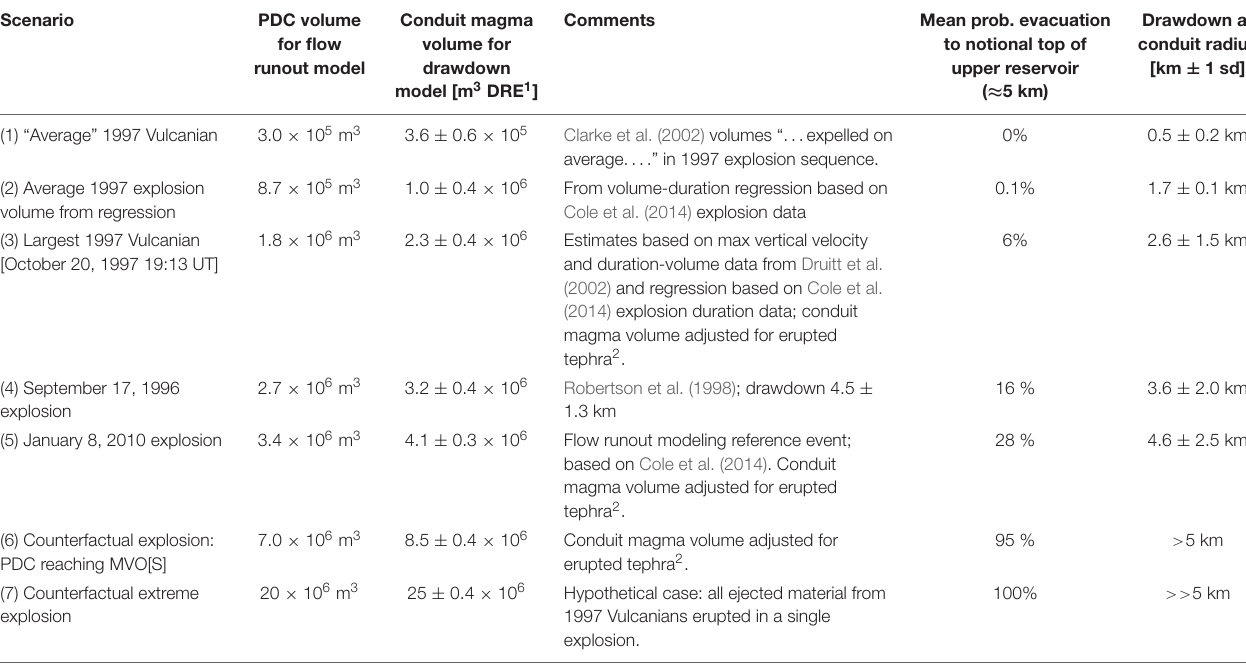
TABLE 1 | Details of explosion scenarios used in the counterfactual analysis and results of drawdown model